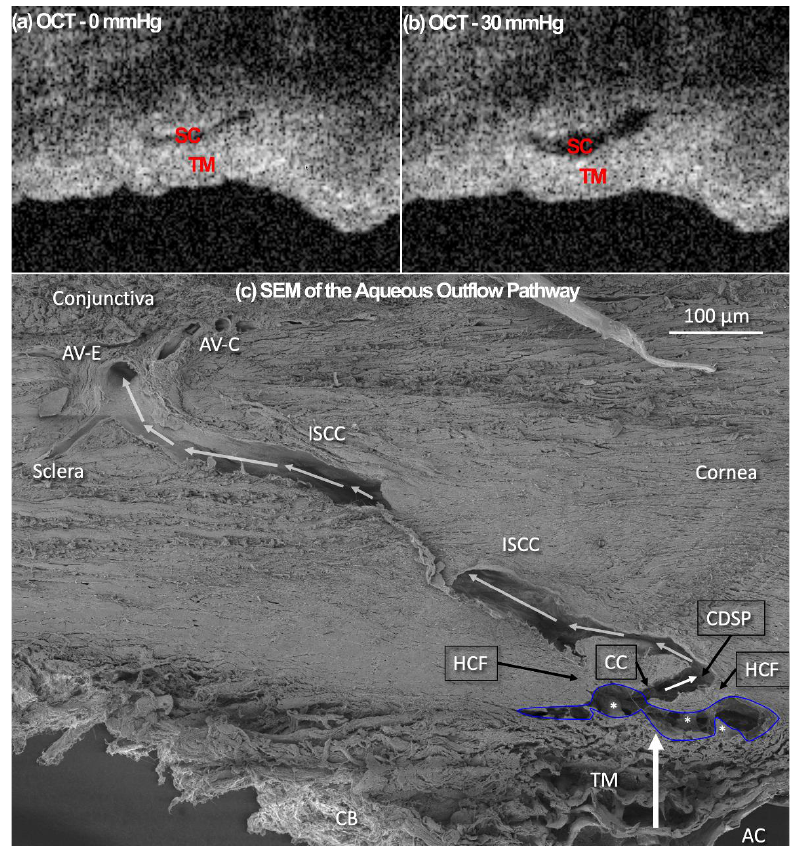
Figure 2. OCT images of the TM at the SC pressures of ( a ) 0 and ( b ) 30 mmHg. ( c ) Pathway of Aqueous Humor: Scanning electron microscopy of aqueous outflow pathway from the anterior chamber (AC) through the trabecular meshwork (TM) to Schlemm ’ s canal (outlined in blue). White arrows denote further aqueous passage through a circumferential deep intrascleral plexus (CDSP). Aqueous then flows through intrascleral collector channels (ISCC) to the episcleral and conjunctival aqueous veins, finally entering the systemic episcleral vein system. A collector channel (CC) entrance leads to a pathway between two hinged collagen flaps or leaflets. SC inlet valvelike structures (*) attach between SC inner wall and the hinged collagen flap (HCF). If the TM moves, the HCF must also move because each attaches to the SIV attachment structures. AV-E, aqueous veins in the episcleral; AV-C, aqueous veins in the conjunctiva; CB, ciliary body. Macaca nemestrina primate eye. From: Johnstone M. Intraocular pressure control through linked trabecular meshwork and collector channel motion. Glaucoma Research and Clinical Advances. Amsterdam: Kugler; 2016; pp. 41–85. The nominal pressure in the SC pressurization system oscillates from 0 to 30 mmHg, but the actual pressure in the SC may not be equivalent to that of the nominal pressure. In our pressurization system, only one end of the SC is cannulated while the other remains open, hence the pressure in SC is unknown. One may argue that significant aqueous will flow into collector channels or exit from the other end of the SC when we elevate the pressure from 0 to 30 mmHg. In addition, the cannula and the tubes may have their own flow resistance that would affect the pressure of the flow before leaving the cannula, as these flow resistance parameters have been fully calculated in our recent publication